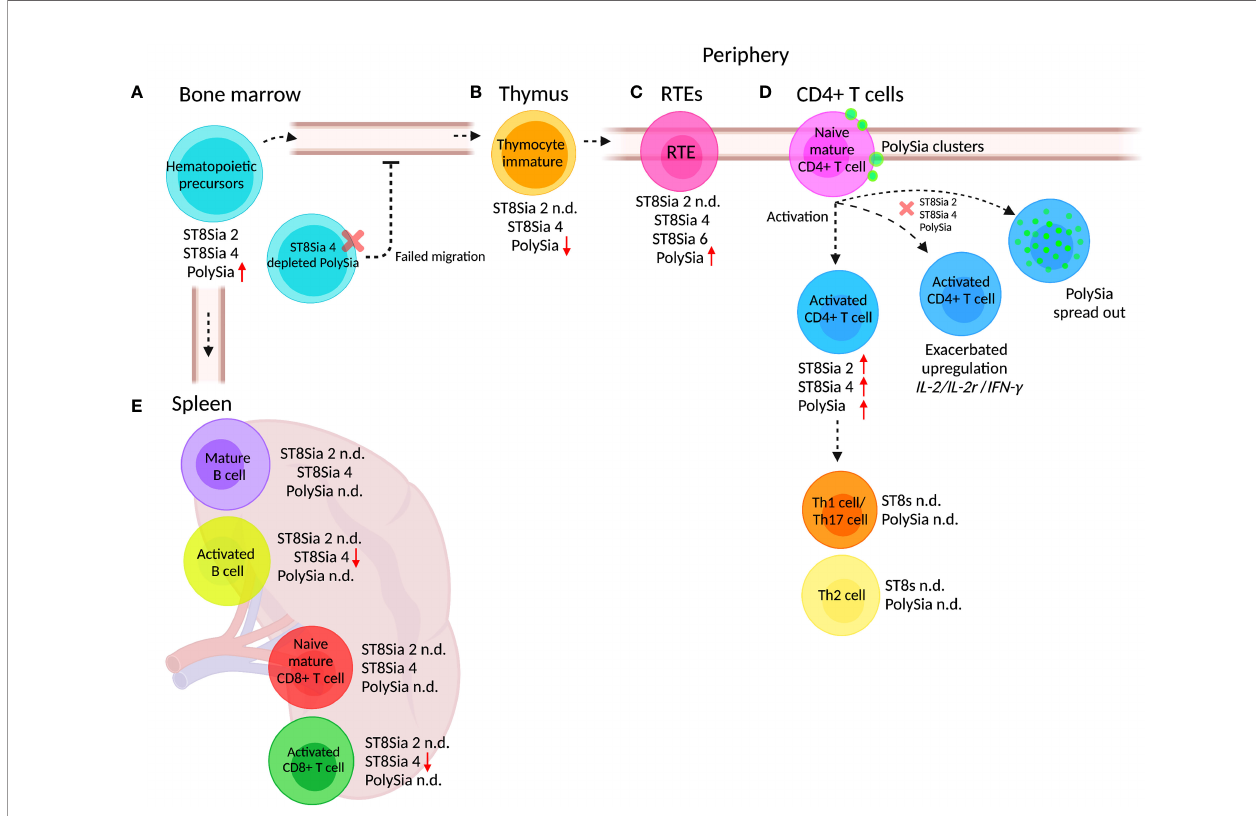
FIGURE 3 | PolySia and polySTs expressed in adaptive immune cells. During differentiation of hematopoietic precursors, maturation, migration, and activation, the cells of the adaptive response suffer changes in the expression of polySia and the polySTs. (A) Hematopoietic precursors derived from BM express ST8Sia 4 and ST8Sia 2, but the polySia is synthesized exclusively by ST8Sia 4. In ST8Sia 4 -/- mice, the BM hematopoietic progenitors fail to exit, migrate, and access the thymus for maturation into T cells. (B) Hematopoietic progenitors mature in the thymus where they differentiate into immature thymocytes which in turn express polySia synthesized by ST8Sia 4. (C) After maturation in the thymus, recent thymic emigrants (RTEs) migrate through the circulation to reach the lymph nodes. The RTEs express the ST8Sia 4 and ST8Sia 6 as well as polySia. (D) Peripheral naive CD4 + T cells express ST8Sia 2, ST8Sia 4, and polySia, which are overexpressed upon in vitro stimulation. When ST8Sia 2 and ST8Sia 4 are downregulated by knockdown (red x) in naive CD4 + T cells, the upregulation of IL-2 , IL-2r (IL-2 receptor), and IFN g genes is exacerbated during activation. (E) Activation of mature B cells reduces ST8Sia 4 expression, but polySia expression has not been analyzed. Naive and activated CD8 + T cells express ST8Sia 4; however, such as occurs with B cells, the polySia expression has not been determined (n.d). Different types of lymphocytes express ST8Sia 4, but polySia expression has not been determined (n.d.). The increase or decrease in polySia expression with respect to the precursor state is indicated with red arrows (up or down). Created with